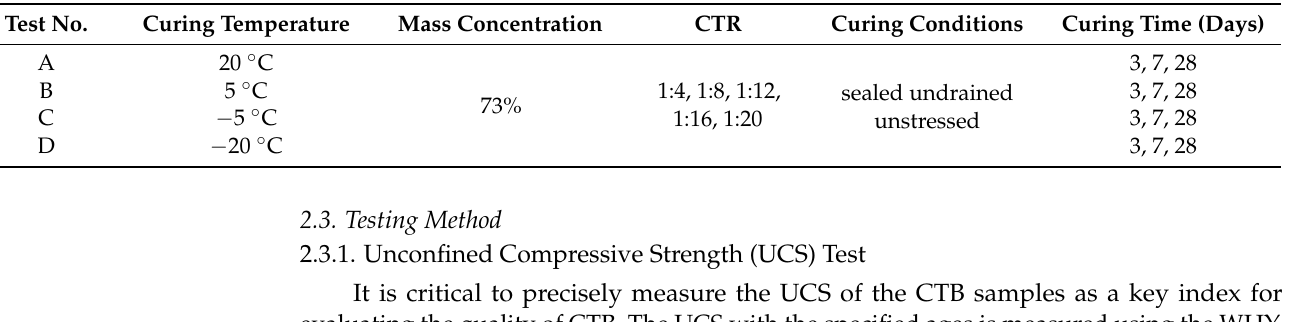
Figure 3. Sample preparation and curing process. Table 3. Summary of the mix compositions of the samples prepared.